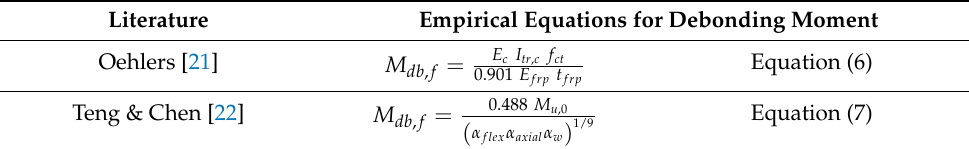
Table 1. Empirical equations for debonding moment from the literature.